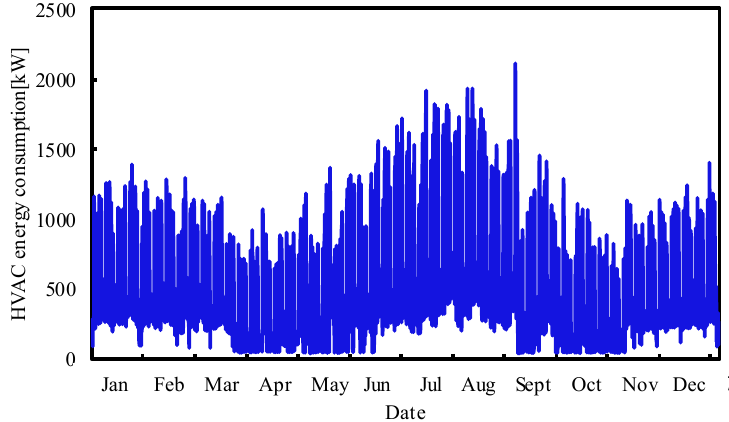
Figure 3. Annual hourly energy consumption of the building.